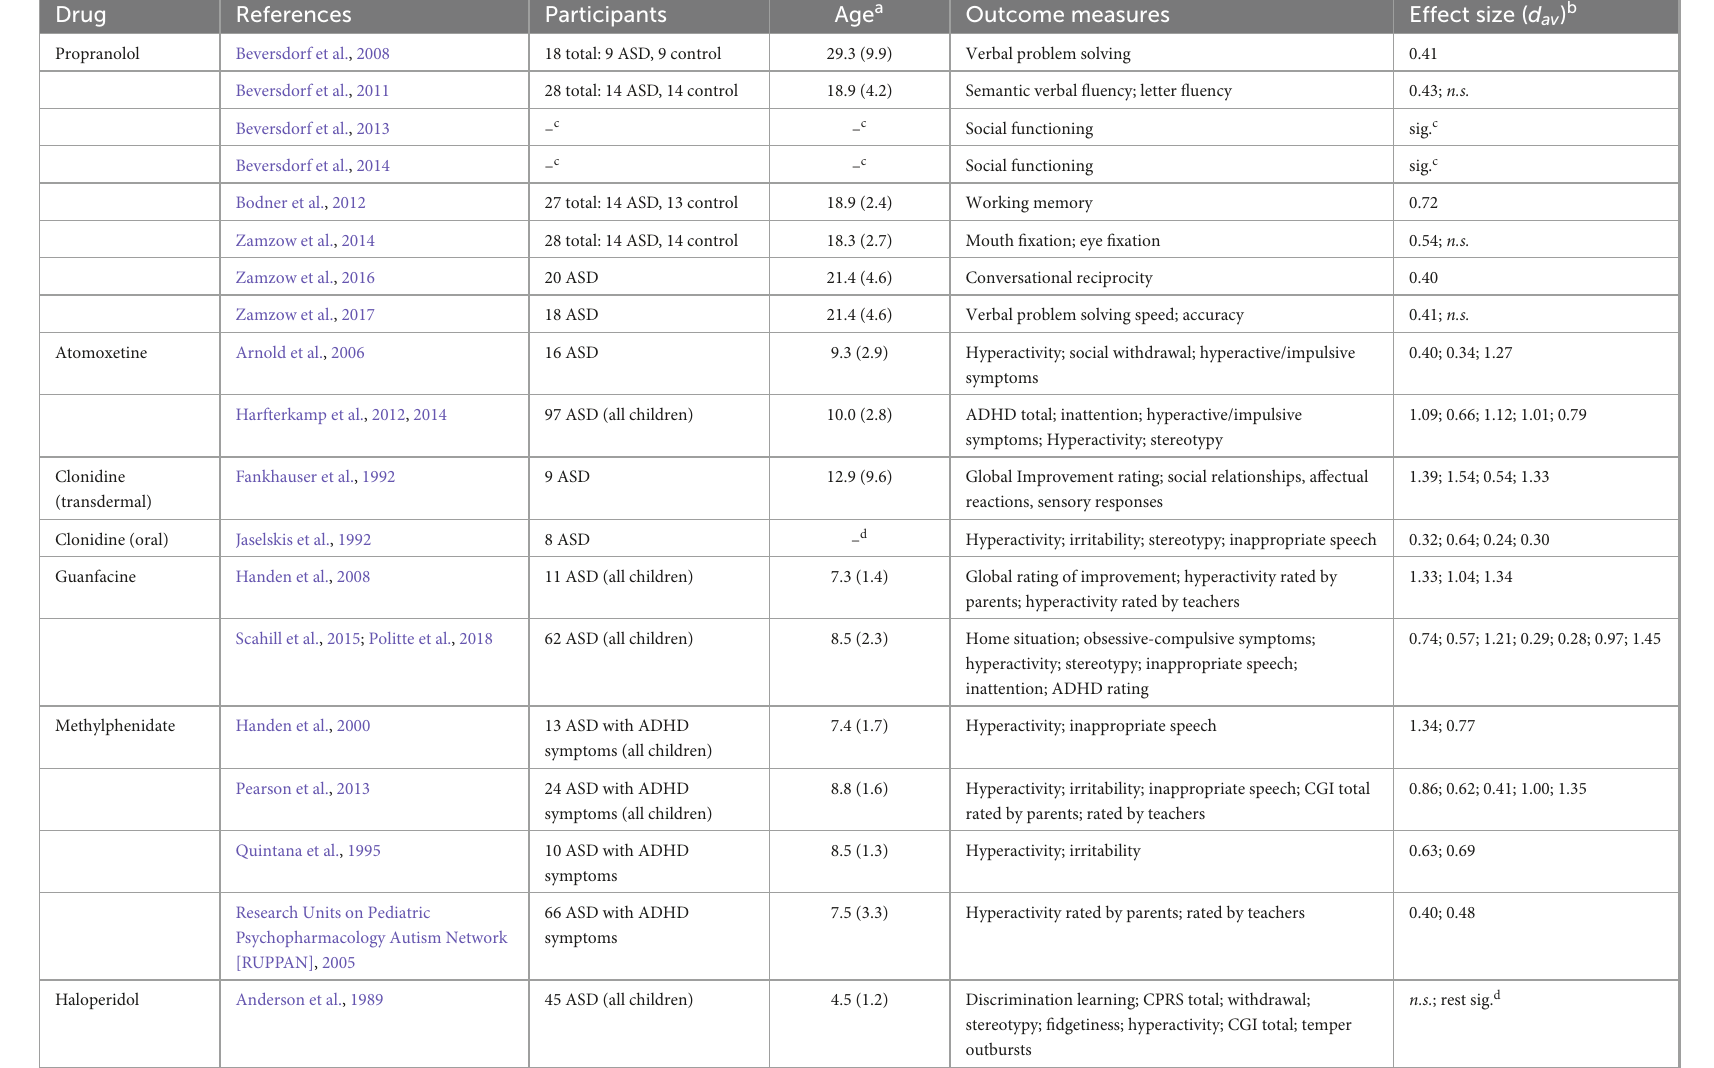
TABLE 1 Overview of human RCTs targeting DA, NE and/or ACh in ASD.